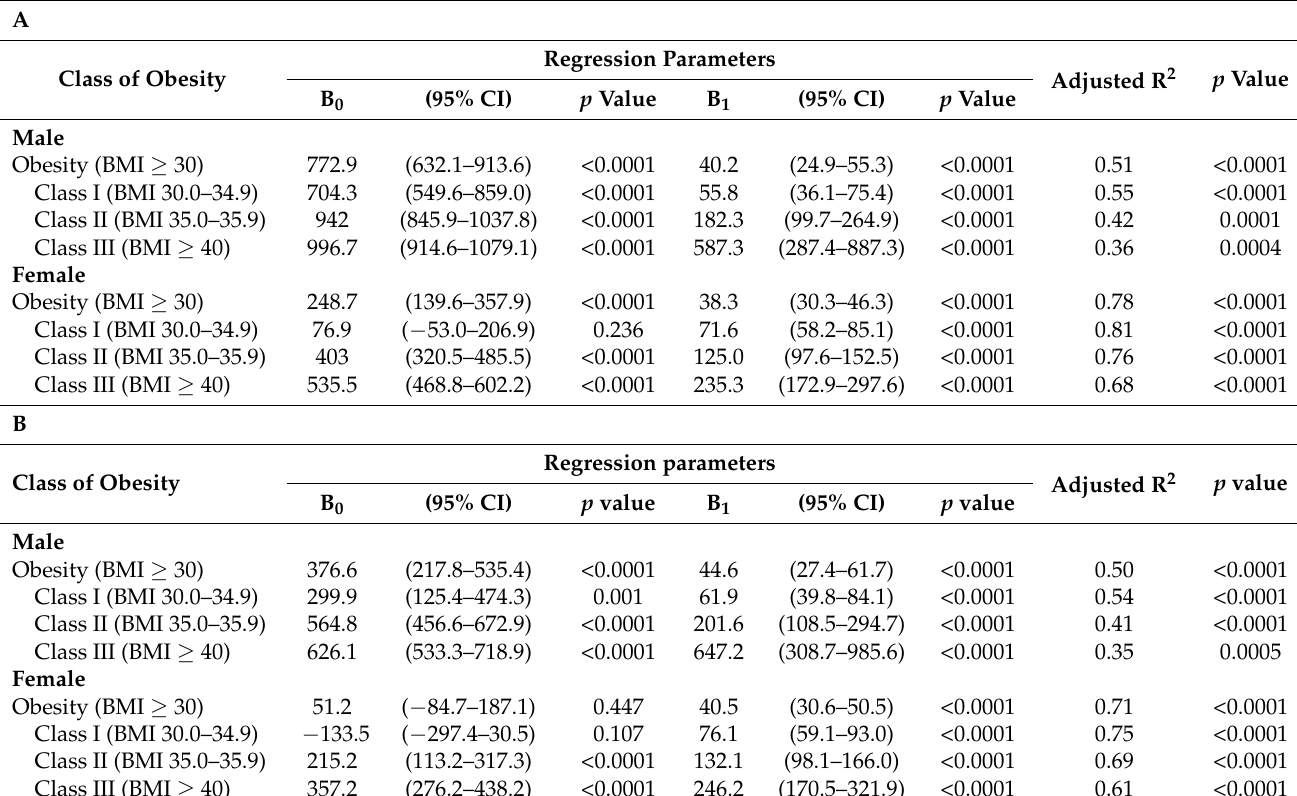
Table 3. Regression analysis on age-standardized incidence (A) and death rates (B) of ischemic heart disease versus prevalence of obesity between 1990 and 2019 in